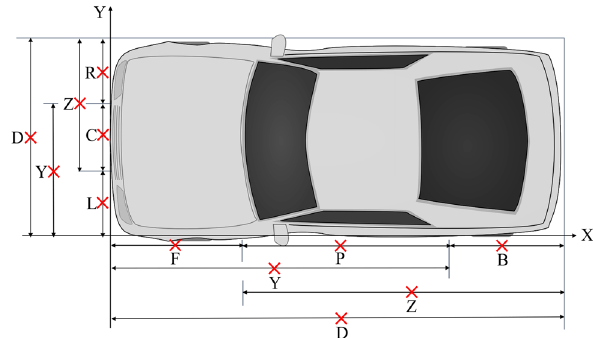
Figure 4: Marking and location of the focal points of the CDC areas ( vehicle: image with a free license from pixabay.com )